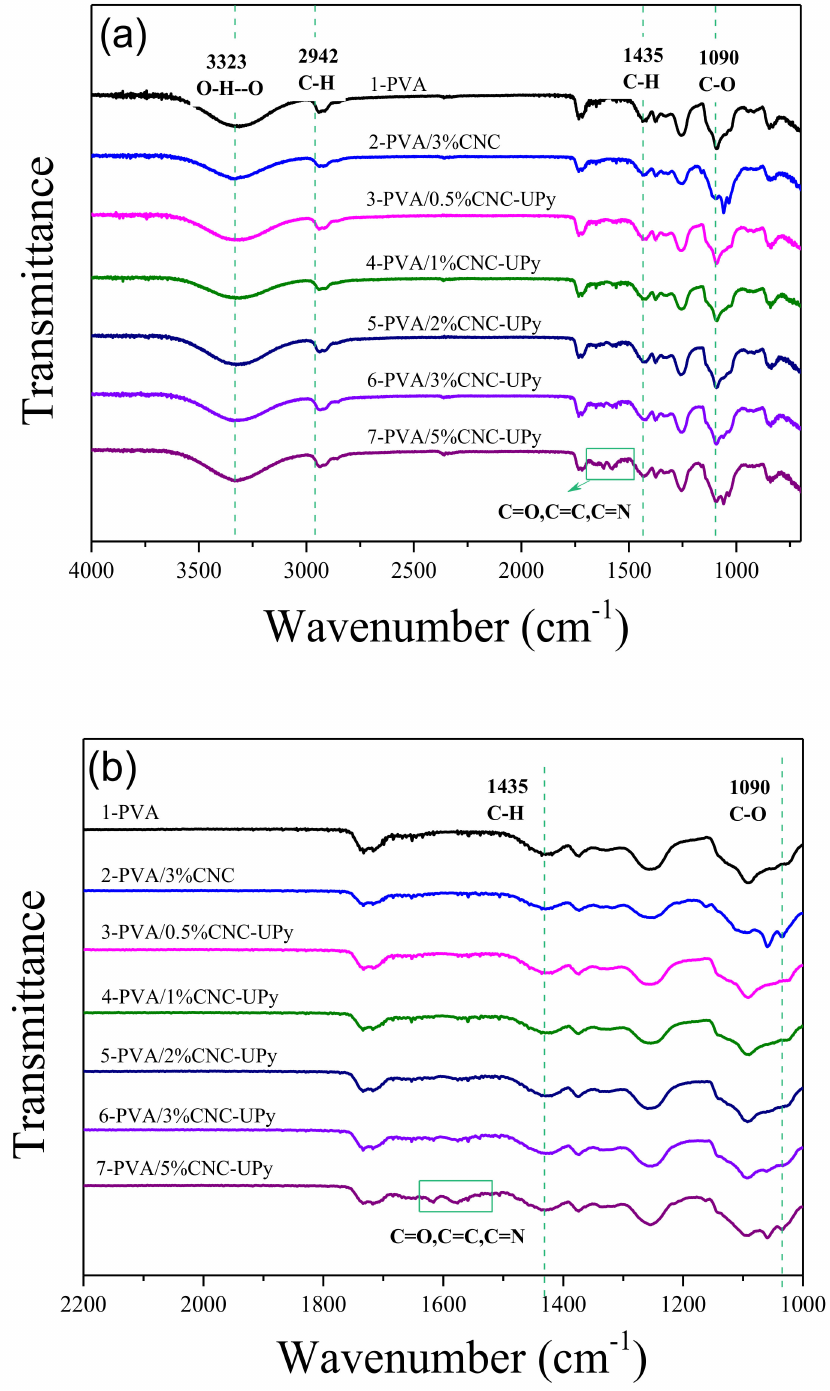
Figure 6. ATR-FTIR spectra of di ff erent PVA composite membranes. ( a ) Whole wavenumber ranges, ( b ) local